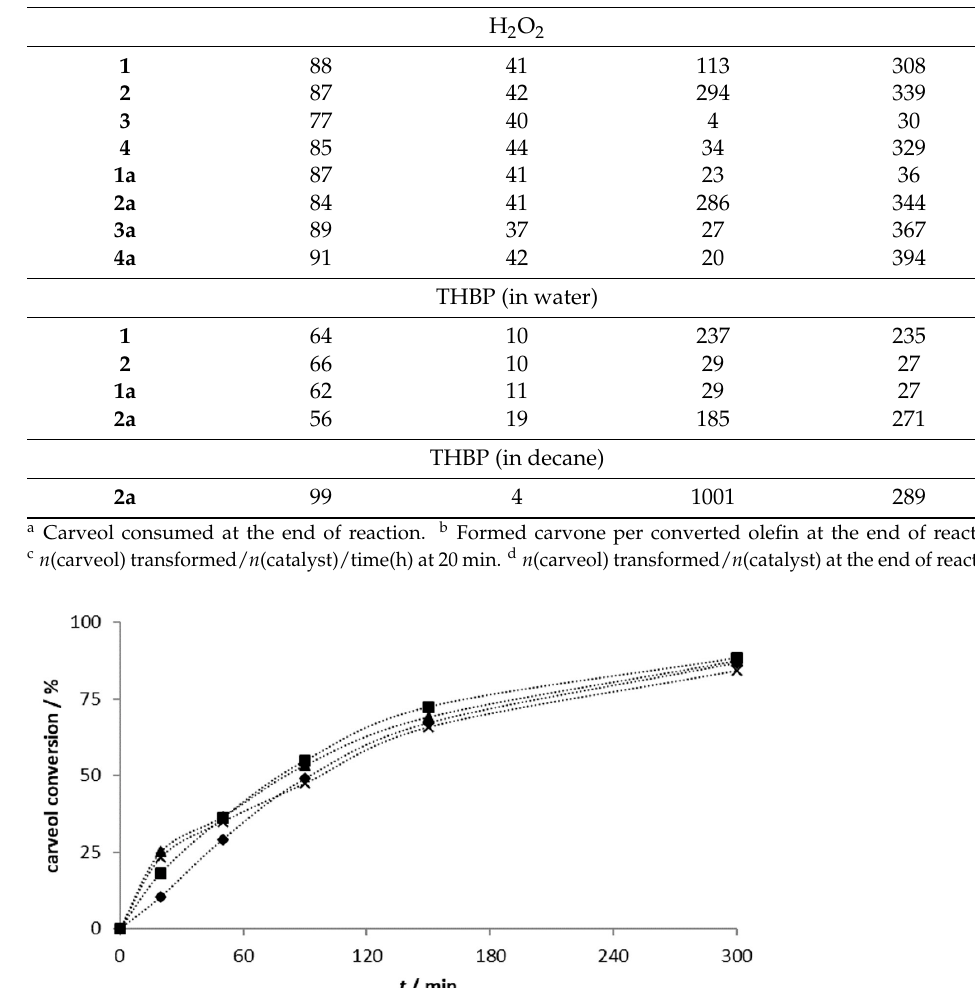
Figure 3. Converted carveol vs . time with molybdenum(VI) (pre)catalyst ♦ complex 1 , ■ complex 1a , ▲ complex 2 , × complex 2a . Conditions: n (Mo): n (substrate): n (THBP aq ) = 1:400:800, T = 353 K.